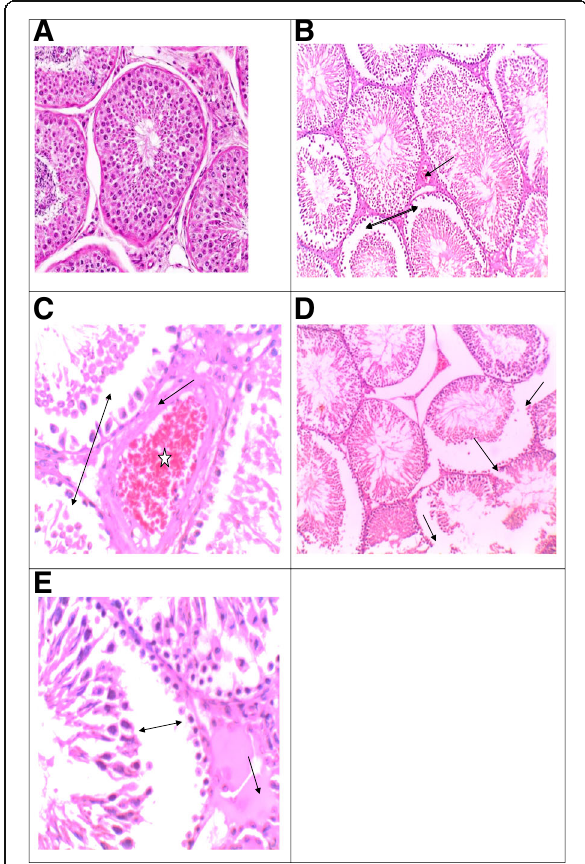
Fig. 2 a Photomicrograph of control testis showing normal testicular architecture with an orderly arrangement of differentiating spermatogenic and sertoli cells in the wall of these miniferous tubules and Leydig cells in the interstitial space (H&E ×400). b Photomicrograph of testis section from treated rat of low dose showing separation of germinal epithelia of seminiferous tubules (black arrow with two heads) and congestion of interstitial spaces with blood (black arrow) (H&E ×200). c Enlarged section of b showing detached degenerative primary spermatogonia from the wall of seminiferous tubules (black arrow with two heads), congested interstitial artery (star), and thickening of its wall (black arrow) (H&E ×400). d Photomicrograph of testis section from treated rat of high dose showing separation and destruction of walls of seminiferous tubules (black arrow with two heads) (H&E ×200). e Photomicrograph of testis section from treated rat of high dose showing pinkish edematous fluid between seminiferous tubules (black arrow) and arrest of spermatogenic layers of seminiferous tubules (black arrow with two heads) (H&E ×400)